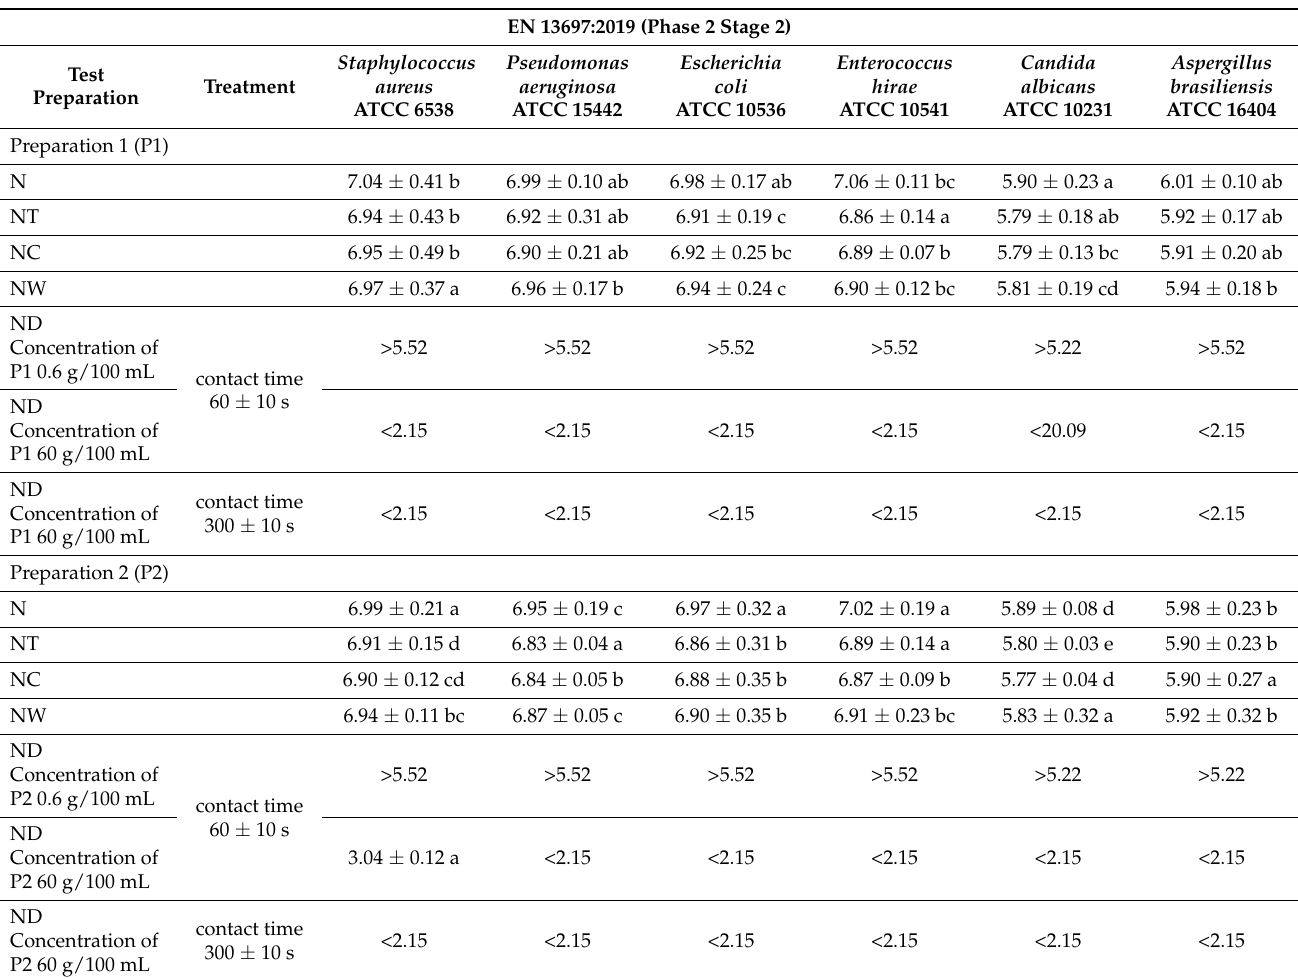
Table 7. The conditions for determining surface disinfection tests of plant preparations by standard EN